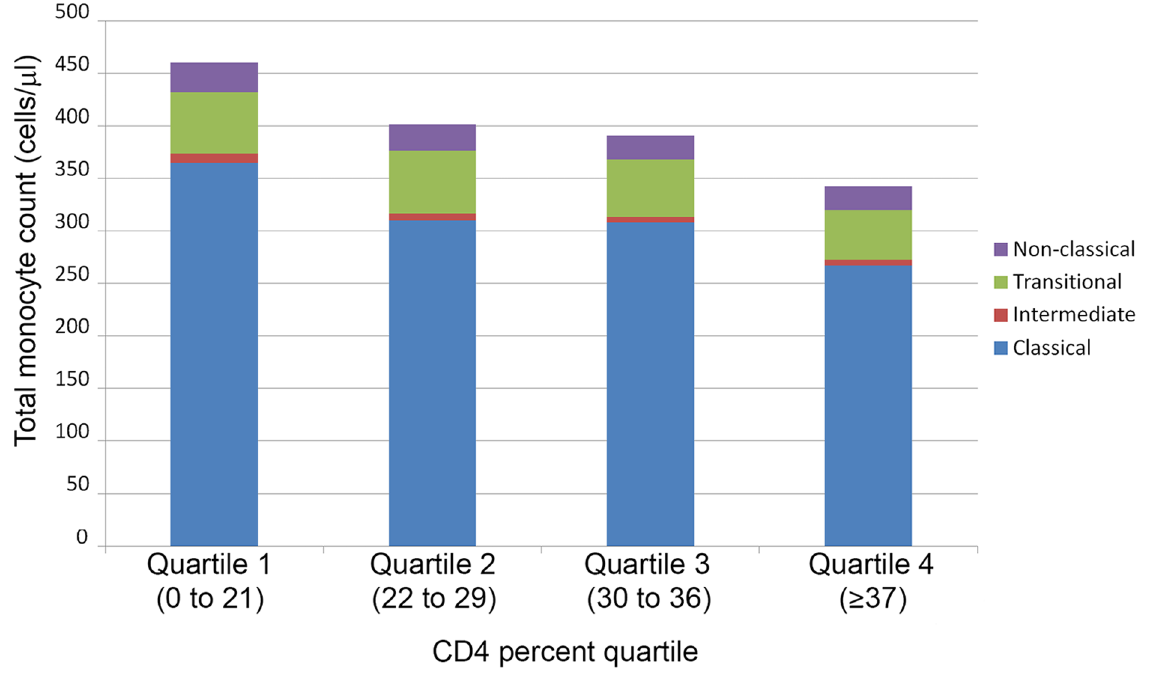
Figure 2. Absolute counts (cells/ m L) of total monocytes by classical, intermediate, transitional and non-classical monocyte subset components by CD4 T cell percent quartiles.